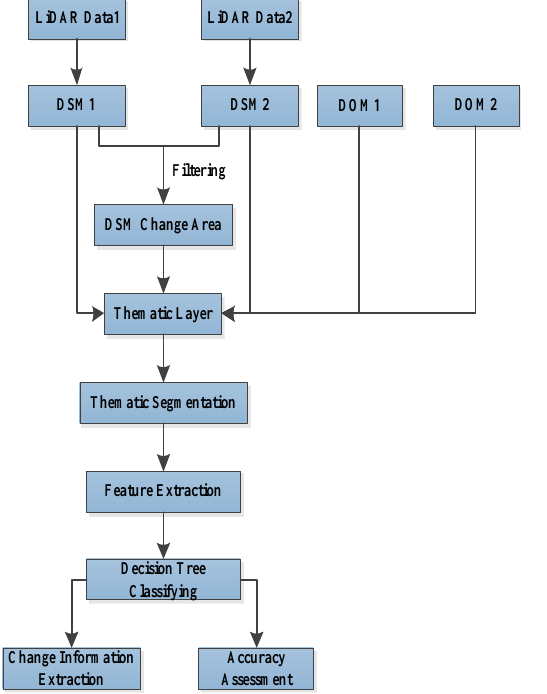
Figure 2. The flow chart of 3D building change